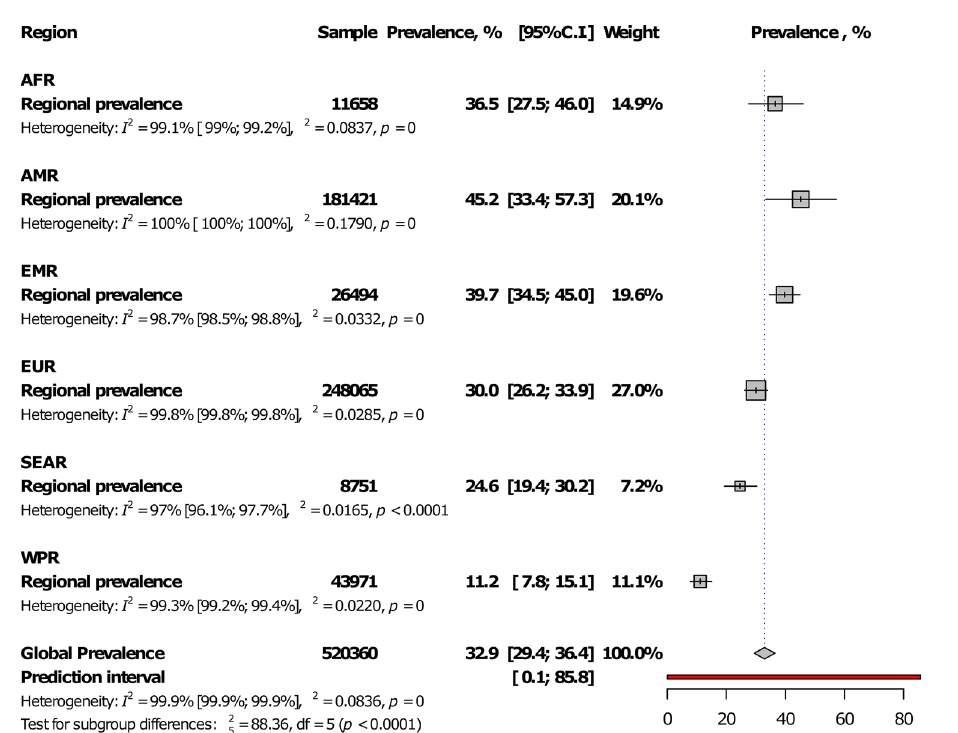
Figure 5. Meta-analysis prevalence of Toxoplasma gondii immunoglobulins G seroprevalence in pregnant women by WHO